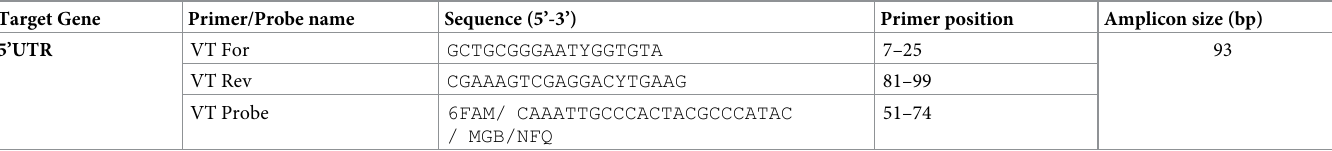
Table 2. New VT-specific primer/probe used for the RT-qPCR and RT-ddPCR assay for VT strains of Citrus tristeza virus . Target Gene